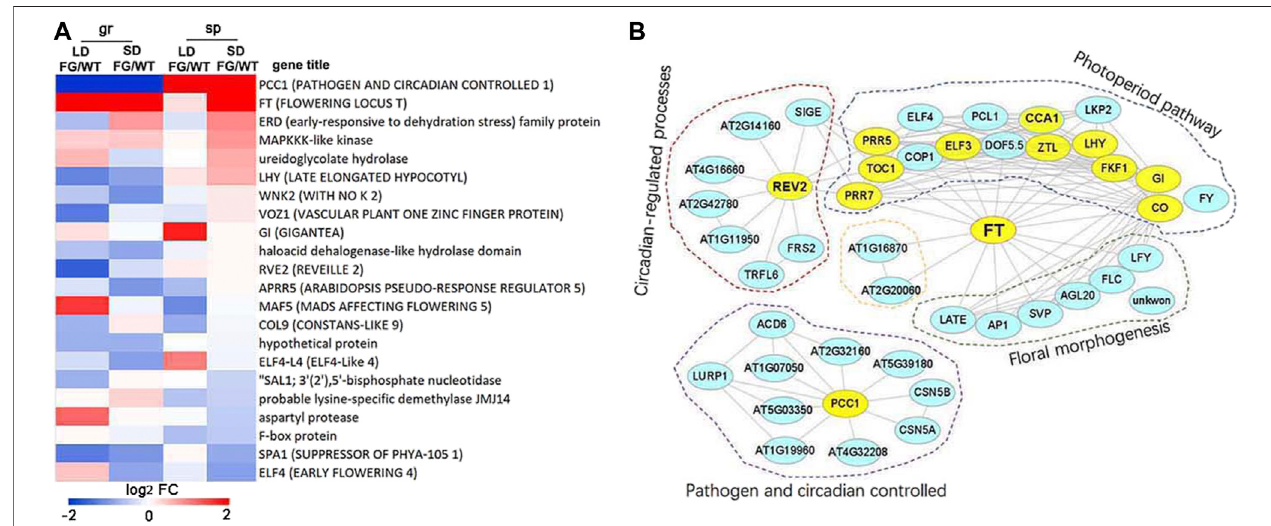
FIGURE9 | The core photoperiod responsivegenesaltered expression levels byexposuree tospace fl ight. (A) Log 2 fl od change ofthe 20core photoperiod genes intheFGunderLDorSDonground(gr)andunderspace fl ight(sp),respectively,incomparisonwiththesegenesinwild-type(WT)underthesamecondition(FG/WT). (B) Diagram of the FT protein interaction networks of the photoperiod responsive genes. The genes, which changed expression levels in response to space fl ight in comparison with their controls on ground, were labelled by color in yellow.